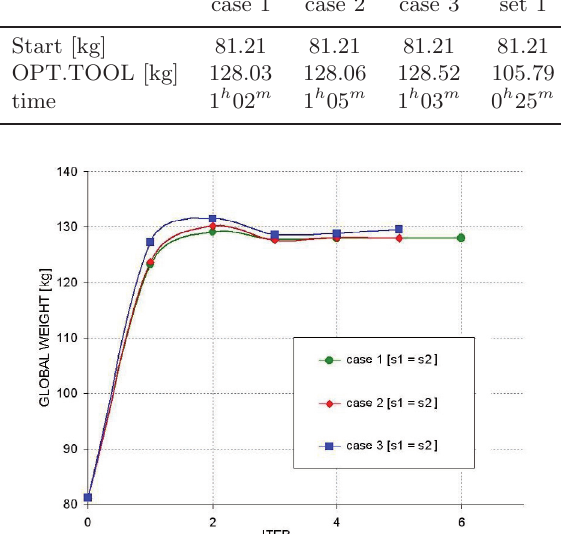
Fig. 4. OPT.TOOL analyses for a wing aircraft. Global weight graphs for different cases.